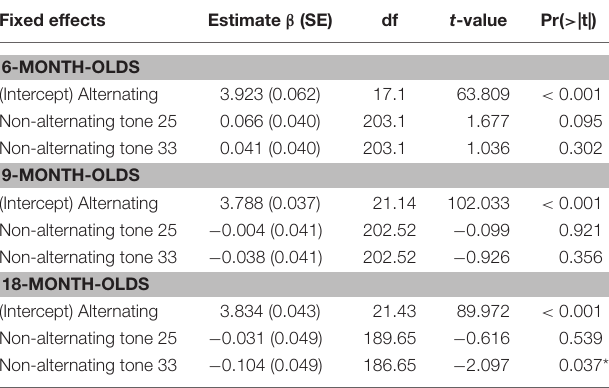
TABLE 5 | Detailed results of the statistical analysis of the familiarization experiment for each age